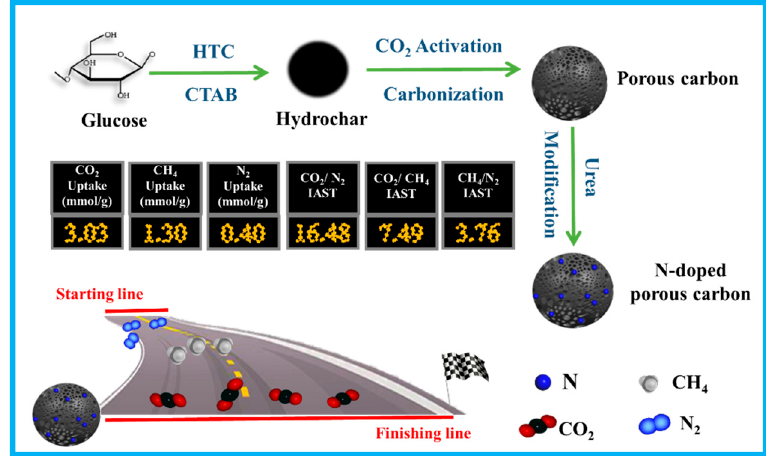
Figure 1. Schematic of the preparation of glucose-based carbon spheres and their applications.